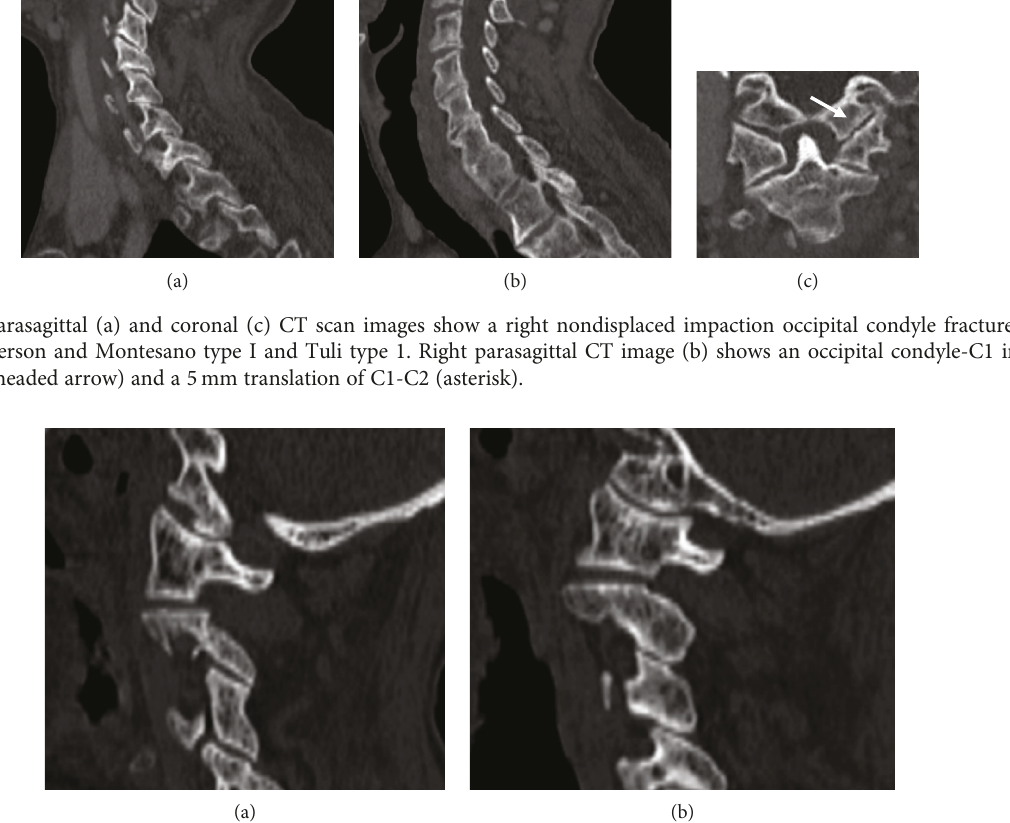
Figure 2: Left (a) and right (b) parasagittal CT scan images demonstrate complete reduction of both the atlantooccipital joint and the atlantoaxial